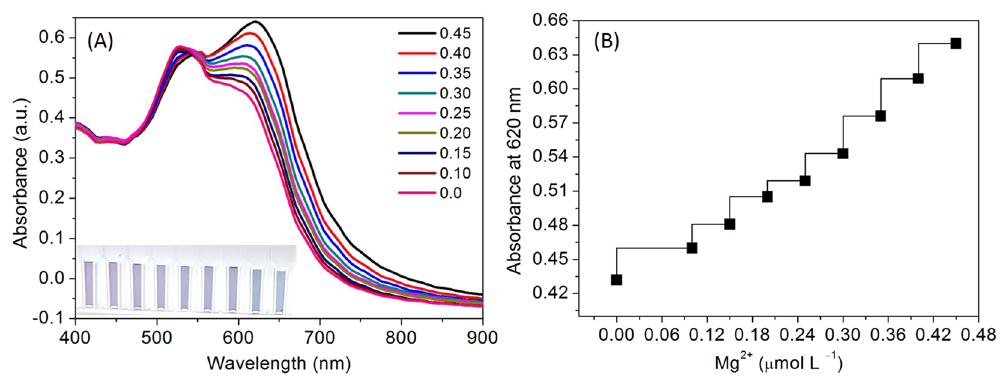
Figure 3. ( A ) Absorbance spectra of the AuNPs in the presence of increasing amounts of Mg 2 + at ambient temperature; ( B ) The curve of absorbance intensity at 620 nm vs. Mg 2 + .